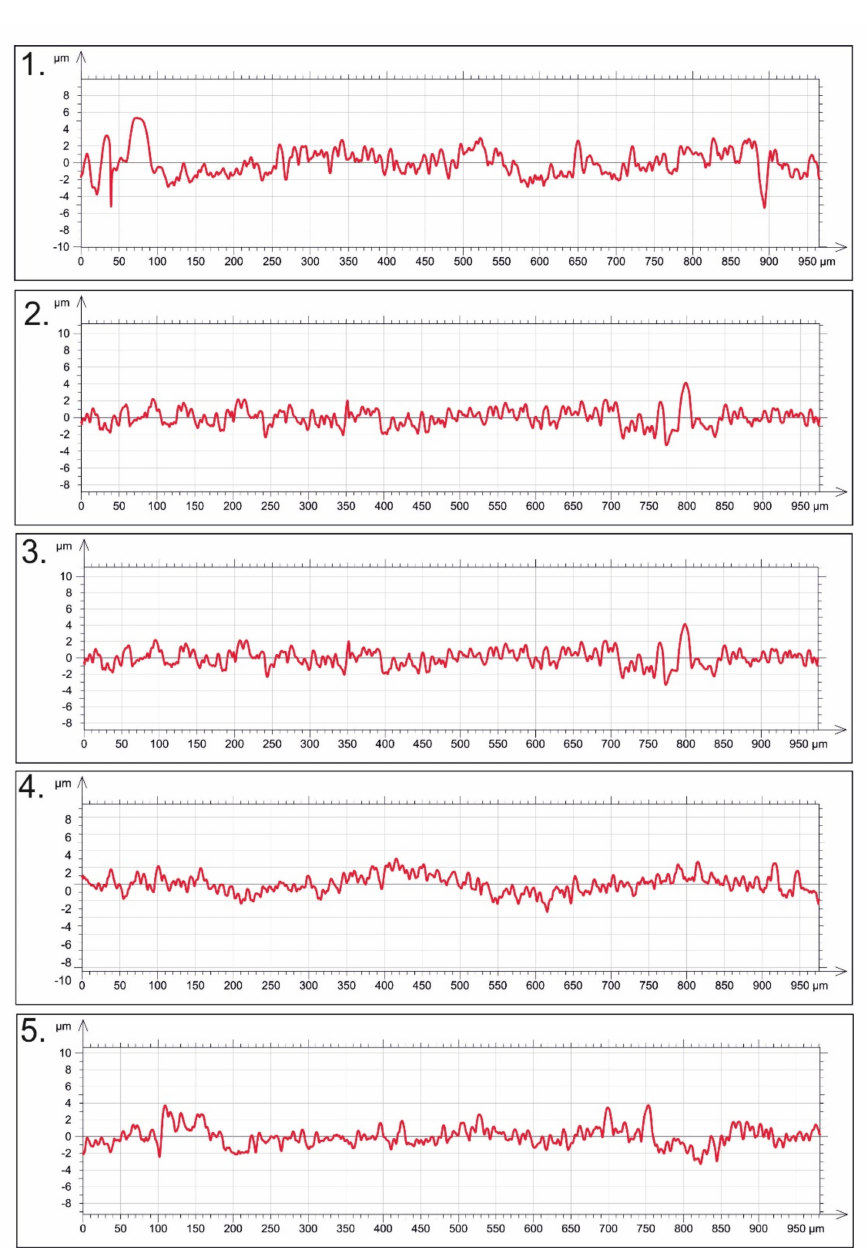
Figure 9. Roughness of the Ti_10_400 sample.